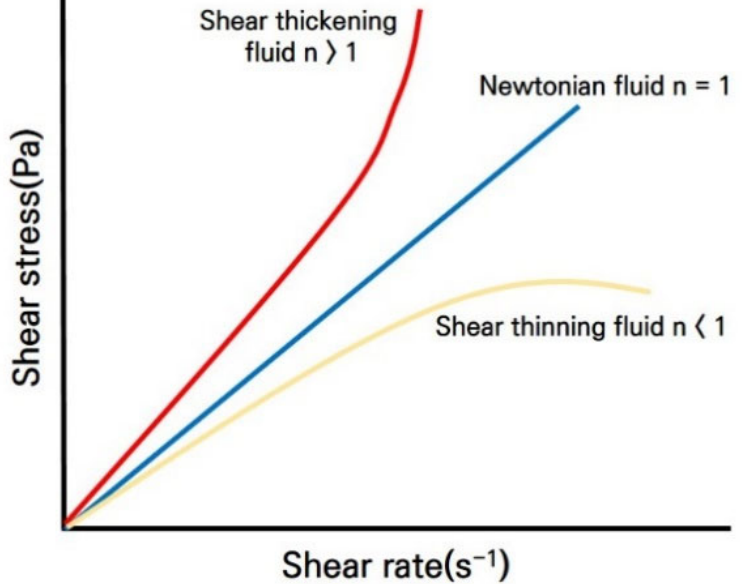
Figure 1. The shear thickening process of a shear thickening fluid.